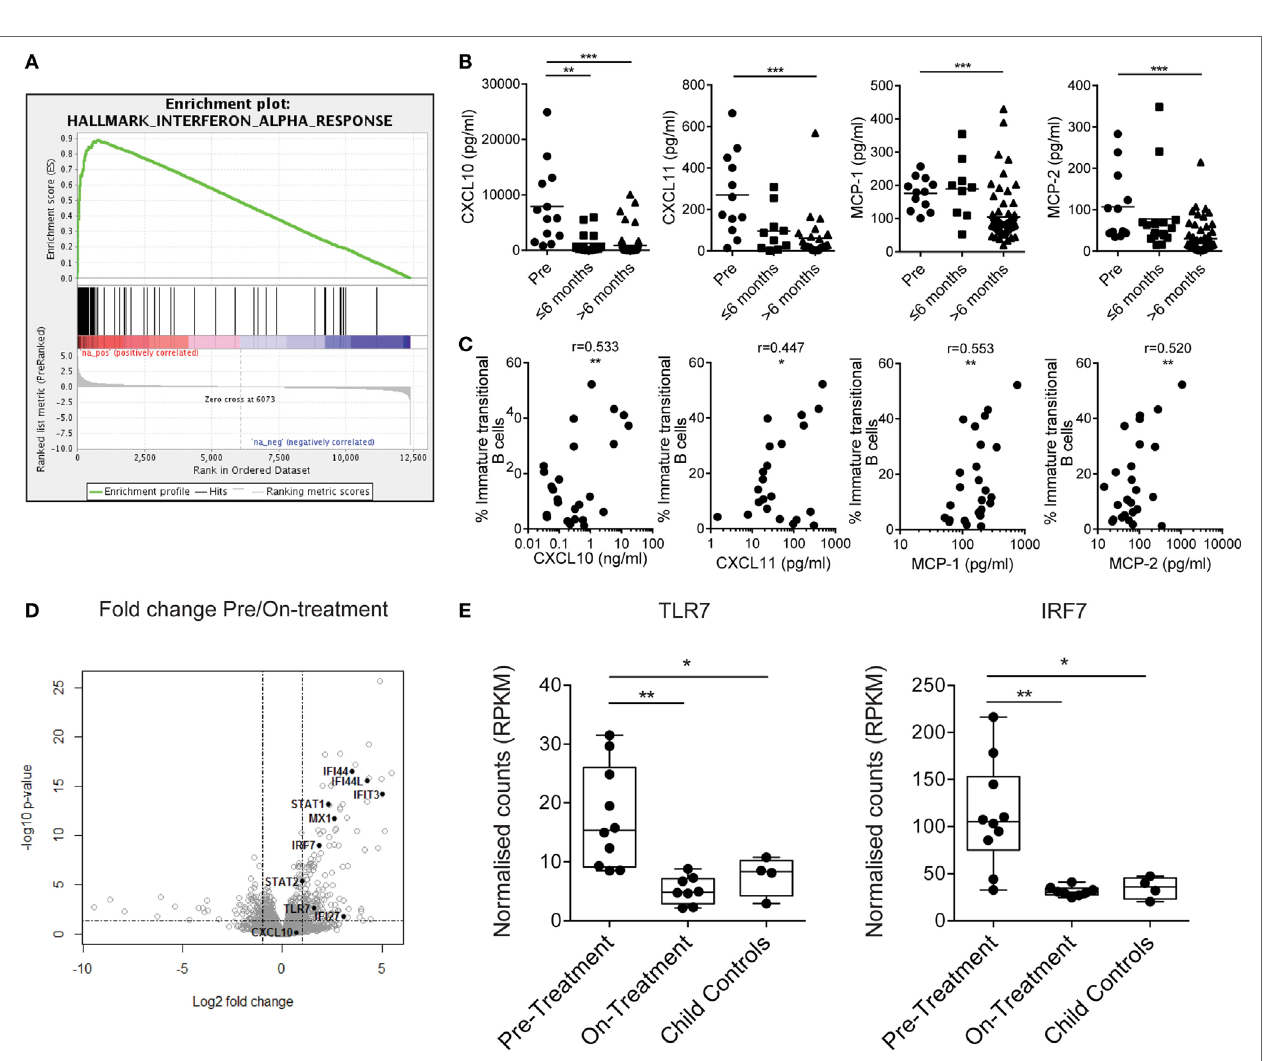
FigUre 2 | Immature transitional B cells are highly proliferative in juvenile dermatomyositis (JDM) patients before treatment. Peripheral blood mononuclear cell (PBMC) samples were stained ex vivo for B cell surface markers CD19, CD24, and CD38 and the intra-nuclear marker of proliferation, Ki-67. (a) Representative flow cytometry plots of Ki-67 expression in immature transitional (top row) and mature B cells (bottom row), in patients and controls. (B) The frequency of Ki-67 + B cells was summarized for total B cells, immature transitional B cells, and mature B cells (left–right) for patients split according to time from treatment start, and for child controls. (c) B cell subpopulations were sorted from patients on-treatment ( n = 3) and child controls ( n = 3) PBMC. DNA extracted from immature transitional (CD19 + CD24 hi CD38 hi CD27 − ) and mature B cells (CD19 + CD24 int CD38 int CD27 − ) were assessed for the levels of kappa-deleting recombination excision circles (KRECs). KREC copies per 10 6 cells were calculated for immature transitional and mature B cells. Lines represent mean values for panel (B) . For panel (c) , bars represent mean